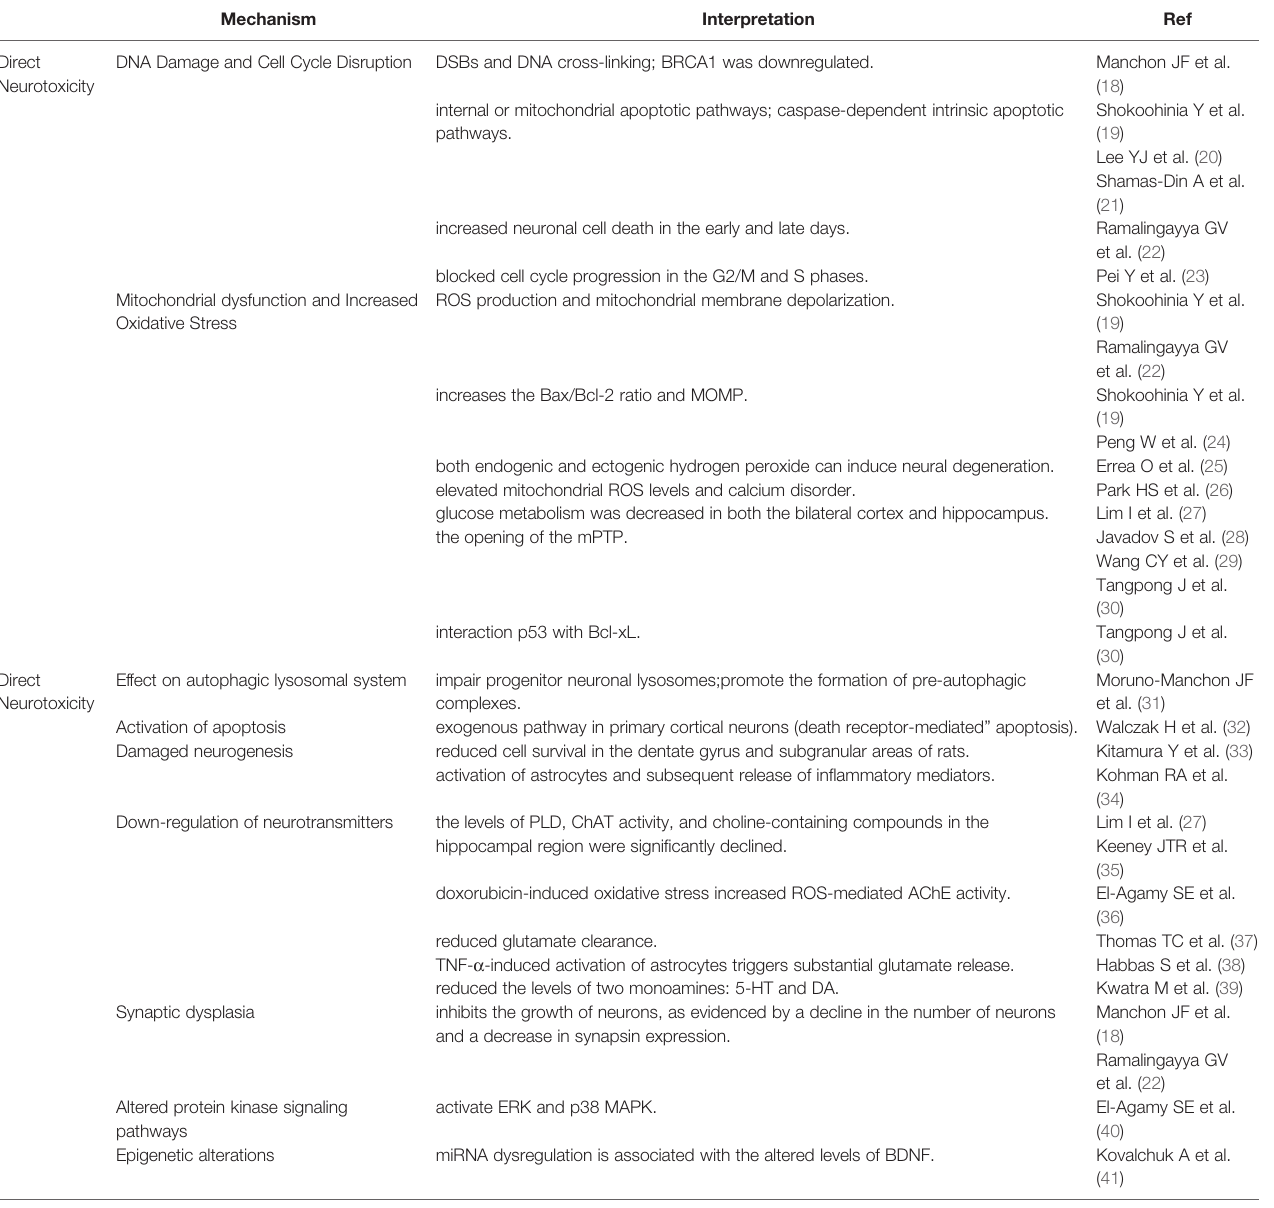
TABLE 1 | The direct neurotoxicity of doxorubicin on